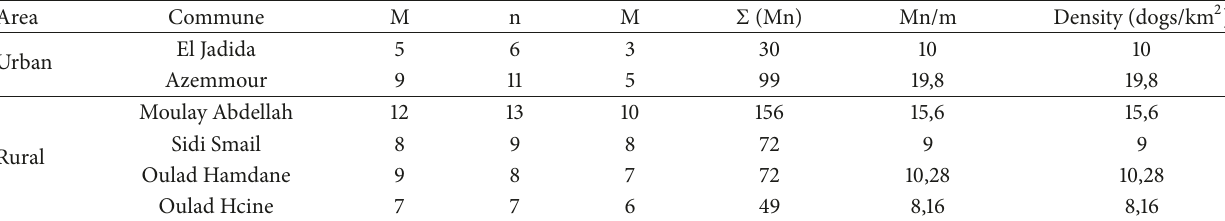
Table 2: Estimation of free roaming dogs and their density.